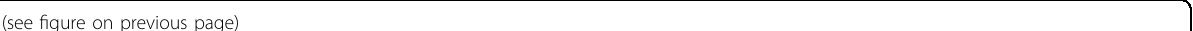
Fig. 2 hACE2-Fc potently neutralized SARS-CoV-2, SARS-CoV, and HCoV-NL63 in vitro, inhibited SARS-CoV-2 S protein-mediated cell – cell fusion and did not induce escape mutants. a hACE2-Fc potently neutralized SARS-CoV-2 pseudotyped virus (pp) and authentic SARS-CoV-2 in vitro. HEK293-ACE2 cells or Vero E6 cells were infected with SARS-CoV-2 pp or SARS-CoV-2 authentic virus in the presence of serially diluted hACE2- Fc, respectively. Luciferase activity in pseudovirus-infected 293-ACE2 cells was detected 40 h post infection and inhibition rates were calculated. Vero E6 cells infected with SARS-CoV-2 authentic virus were fi xed 1 day after infection. Focus reduction neutralizing assay was performed as described in the experimental procedures. Date points are mean ± SEM of three biological replicates with two independent experiments. b HEK293-ACE2 cells or Huh7 cells were infected with SARS-CoV pp or HCoV-NL63 pp in the presence of serially diluted hACE2-Fc, respectively. Luciferase activity in pseudovirus-infected cells was detected 40 h post infection and inhibition rates were calculated. Date points are mean ± SEM of three biological replicates with two independent experiments. c hACE2-Fc potently neutralized SARS-CoV-2 pp mutant bearing D614G or V367F. Date points are mean ± SEM of three biological replicates with two independent experiments. d hACE2-Fc potently neutralized SARS-CoV-2 emerging B.1.1.7 and B.1.351 variants. Date points are mean ± SEM of three biological replicates with two independent experiments. e hACE2-Fc potently neutralized SARS- CoV-2 variants B.1.617.1 and B.1.617.2. Date points are mean ± SEM of three biological replicates with two independent experiments. f Summary of IC 50 of neutralization assay. g hACE2-Fc WT and mutant did not promote authentic SARS-CoV-2 infection at a wide range of concentration. Date points are mean ± SEM of six biological replicates with two independent experiments. h hACE2-Fc inhibited SARS-CoV-2 S protein-mediated cell – cell fusion. HEK293T cells transfected with SARS-CoV-2 S and pEGFP were preincubated with serially diluted hACE2-Fc WT or mutant for 1 h at 37 °C. Cells were then mixed with Huh7 cells for membrane – membrane fusion. Cells transfected with pEGFP vector were used as negative control. After 24 h, the formation of syncytium was observed. Scale bars (white), 200 µm. Data are representative of three independent experiments. i Sequencing of hACE2- Fc escape mutant viruses. Four rounds of passage were performed in SARS-CoV-2-infected Vero E6 cells and Calu-3 cells in the presence of hACE2-Fc ranging from 0.4× to 8× IC 50 . Viral RNA was extracted and sequenced. Two independent passages of SARS-CoV-2 with/without hACE2-Fc WT were